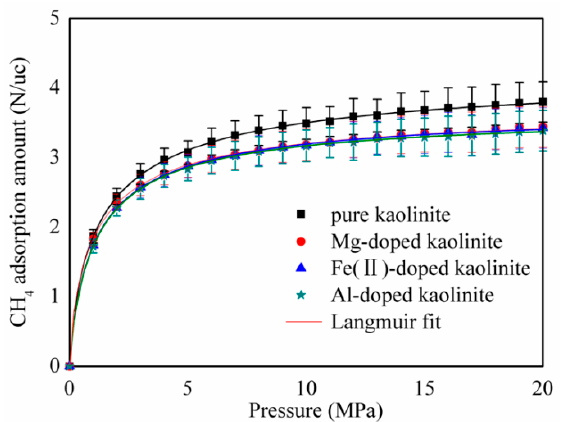
Figure 2. Absolute adsorption amount of CH 4 on pure and Mg-, Fe(II)-, and Al-doped kaolinite at a temperature of 293.15 K. Error bars indicate the standard deviations. Table 1. Langmuir constants obtained by fitting the Langmuir model to the absolute adsorption amount of CH 4 on pure and Mg-, Fe(II)-, and Al-doped kaolinite at 293.15 K.